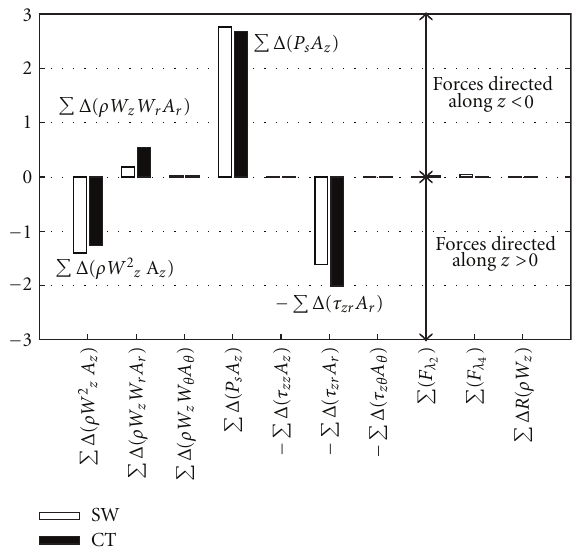
Figure 13: CBUAA with and without CT: balance of the axial momentum